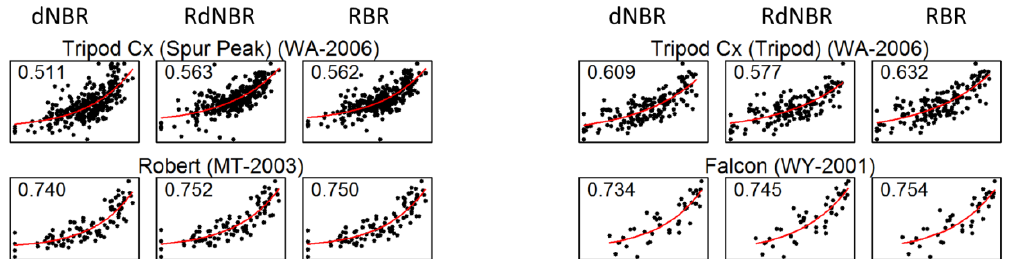
Figure A1. Scatterplots depicting the relationship between three remotely sensed severity metrics (y-axis) and CBI (x-axis) when the dNBR term was excluded from the equations. offset The state abbreviation and year in which the fire occurred are shown in parentheses. The red lines represent the nonlinear fits. The coefficient of determination (R 2 ) is shown for each fit. Boxplots in the lower right summarize the R 2 of all fires for each metric; boxes represent the inter-quartile range, whiskers extend to the 5th and 95th percentiles, horizontal lines represent the median, solid dots the mean, and asterisks indicate the R 2 of 1,681 plots with a single model. All fits are statistically significant (p <